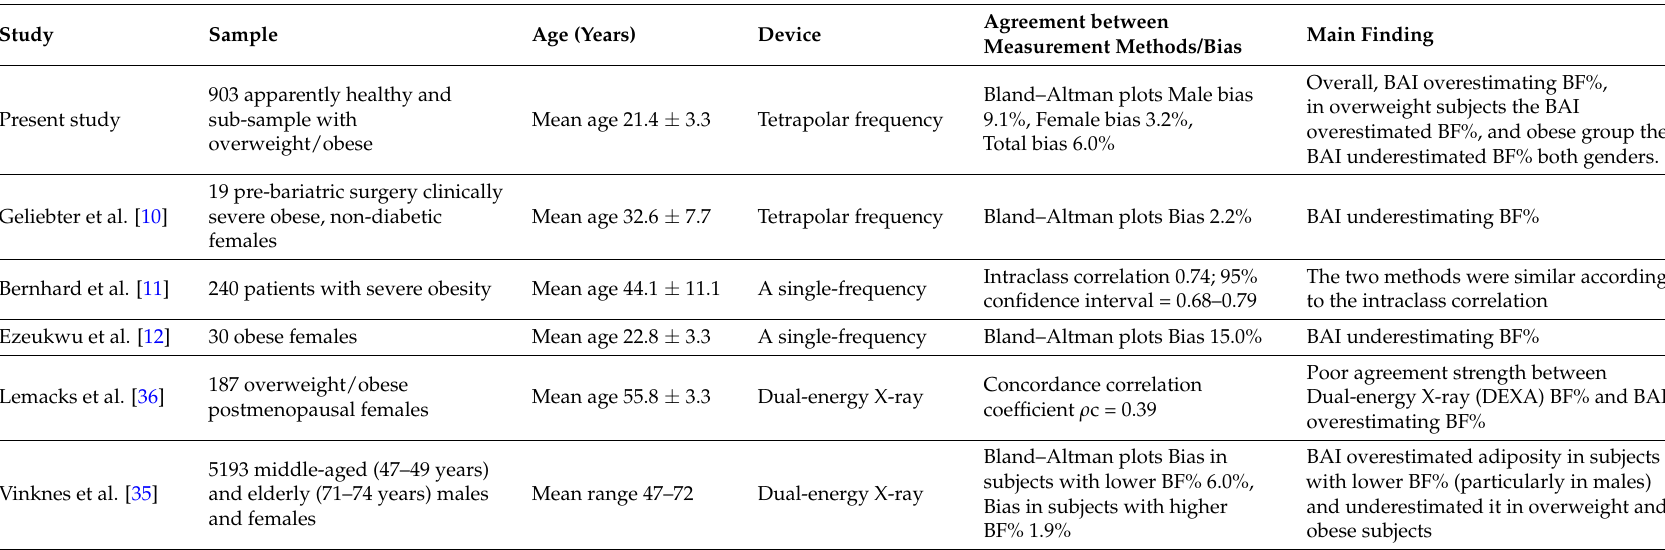
Table 3. Comparison of BAI in different